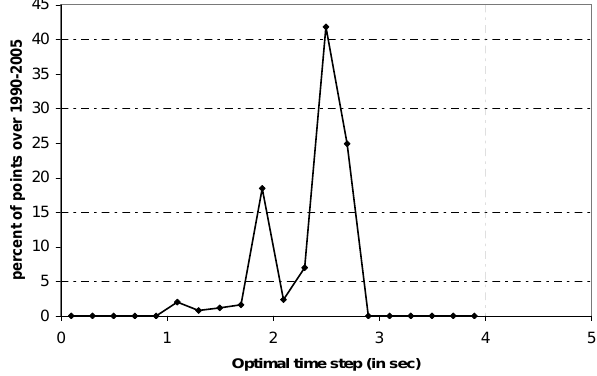
Fig. 1. Distribution of the optimal time step that can be used in the Salammbˆo code. The statistic has been performed over more than one solar cycle, from 1990 to